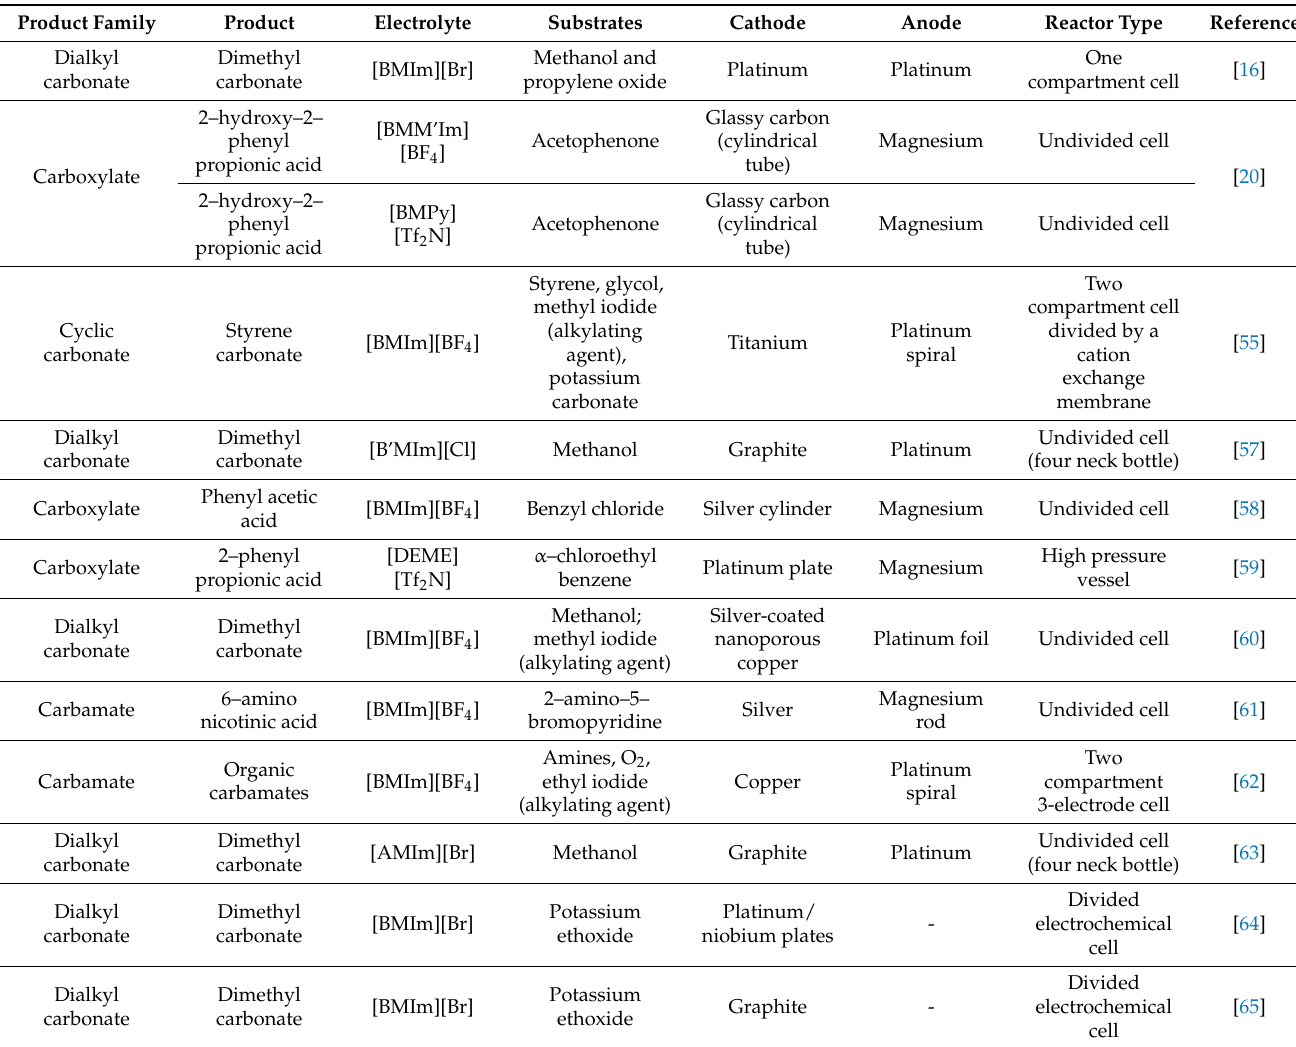
Table 4. Summary of IL-based electrolytes used in the electrochemical conversion of CO 2 via the transformation route. Product